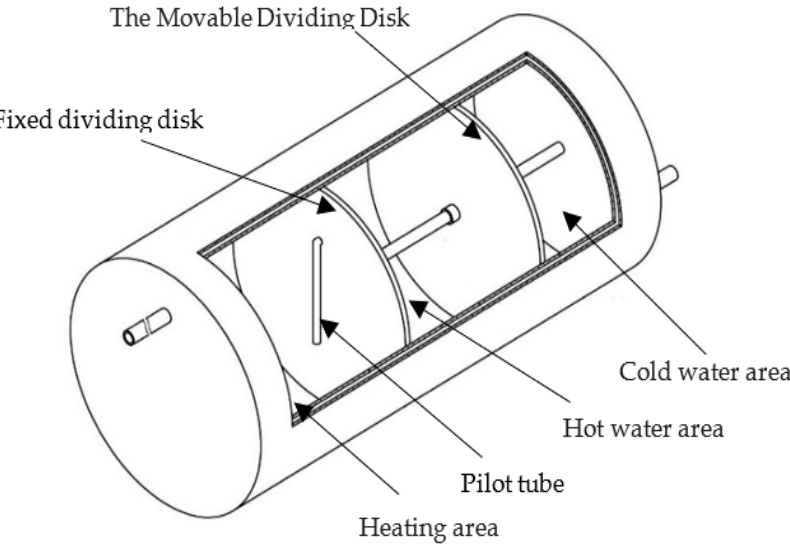
Electronics 2020 , 9 , x FOR PEER REVIEW Figure 7. Cross-section view of 4th generation solar water heating tank. Figure 7. Cross-section view of 4th generation solar water heating tank.